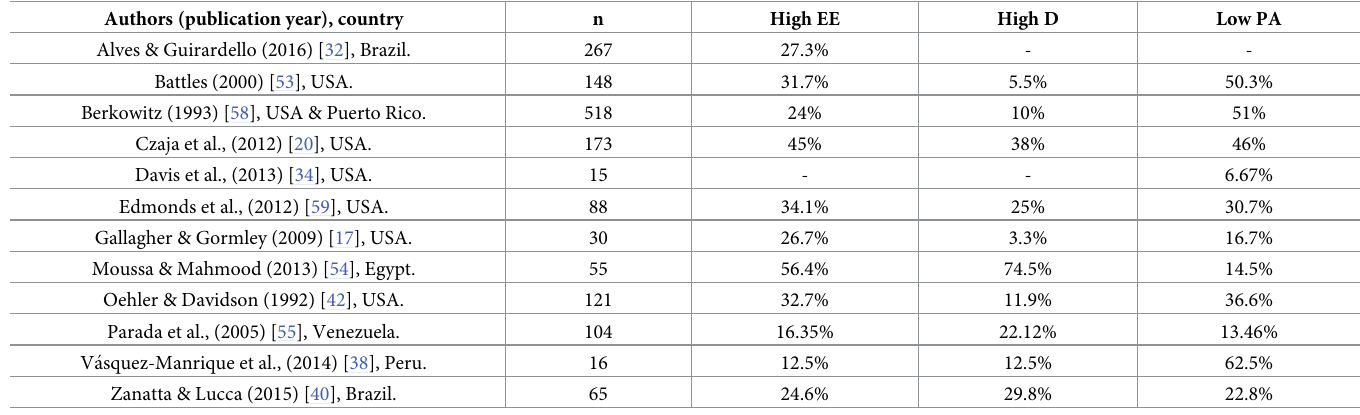
Table 2. Prevalence of high EE, high D and low PA. Authors (publication year), country